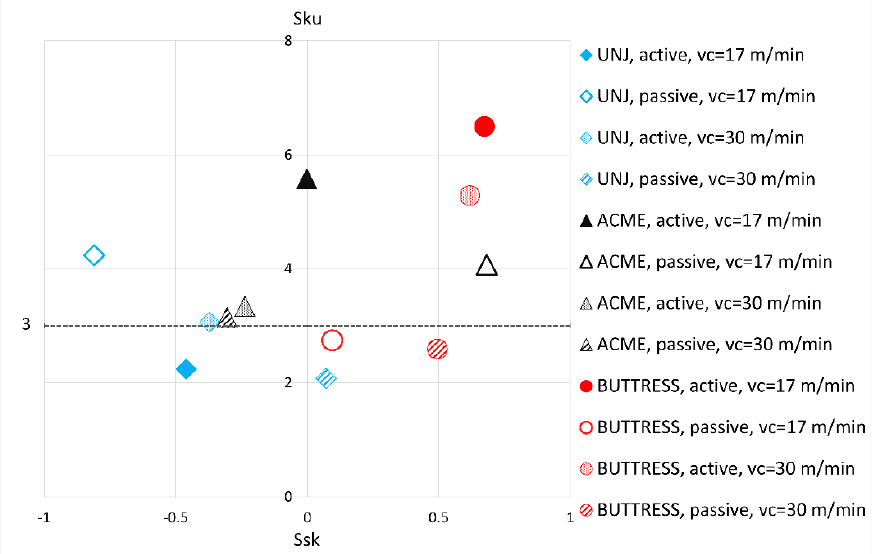
Figure 6. Sku – Ssk map for the measured surfaces.